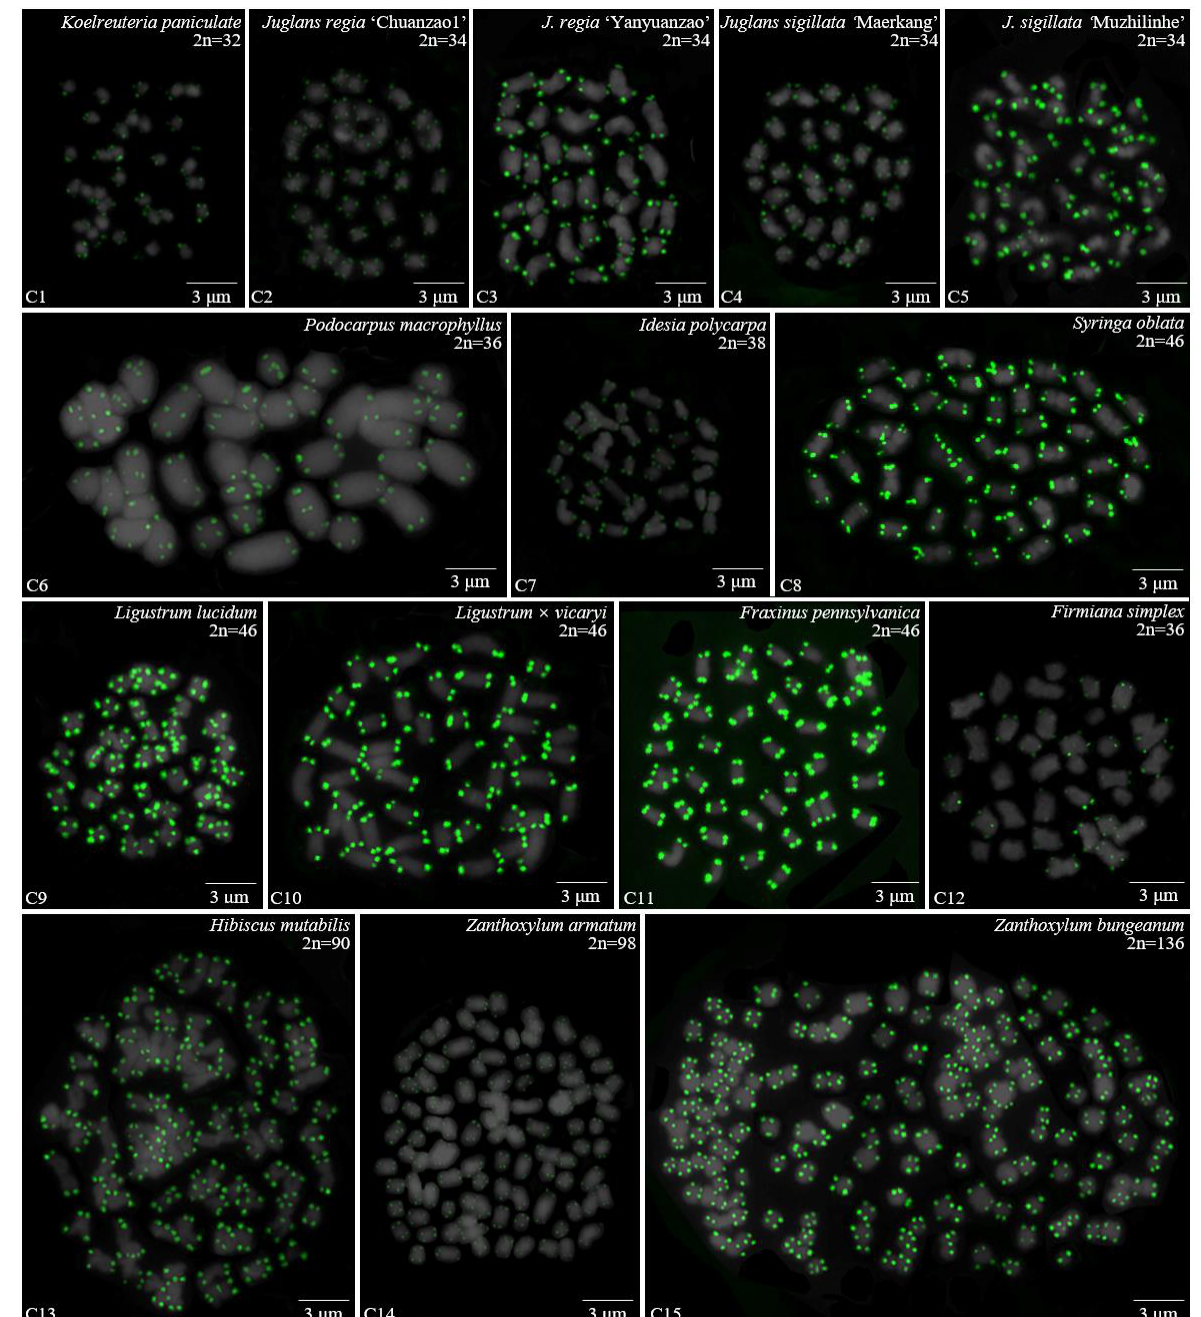
Figure 3. Oligo-FISH depicting the (AG 3 T 3 ) 3 present in 15 woody plants. All chromosomes in C1–C15 are from metaphase. Oligo-probe (AG 3 T 3 ) 3 is exhibited by green signals: ( C1 ) K. paniculata , 2n = 32; ( C2 ) J. regia ‘Chuanzao1’ , 2n = 34; ( C3 ) J. regia ‘Yanyuanzao’ , 2n = 34; ( C4 ) J. sigillata ‘Maerkang’, 2n = 34; ( C5 ) J. sigillata ‘Muzhilinhe’ , 2n = 34; ( C6 ) P. macrophyllus , 2n = 36; ( C7 ) I. polycarpa , 2n = 38;